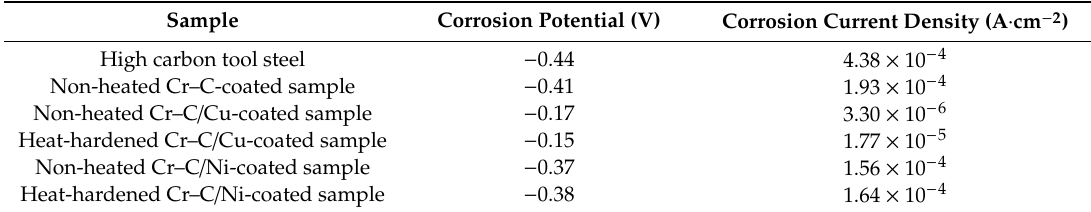
Figure 4. Anodic polarisation behaviour of the non-heated and heat-hardened Cr–C, Cr–C / Ni- and Cr–C / Cu-coated samples. Table 2. Anodic polarisation data of the non-heated and heat-hardened Cr–C, Cr–C / Ni- and Cr–C / Cu-coated